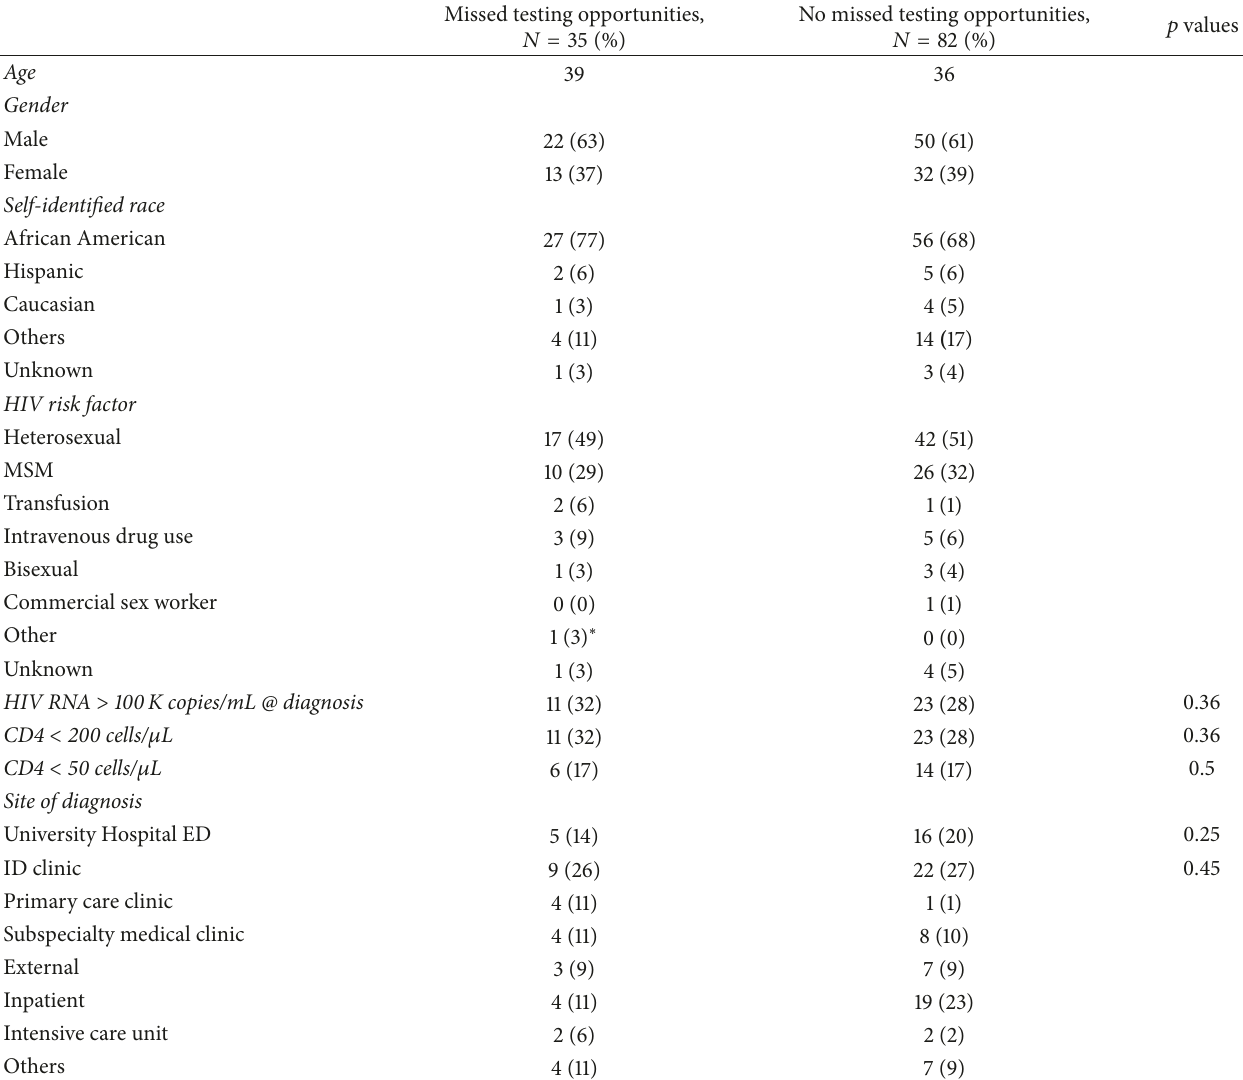
Table 2: Comparison of newly diagnosed patients with and without missed testing opportunities at University Hospital HIV Clinic, Newark, New Jersey, 2013-2014. Missed testing opportunities, 𝑁 = 35